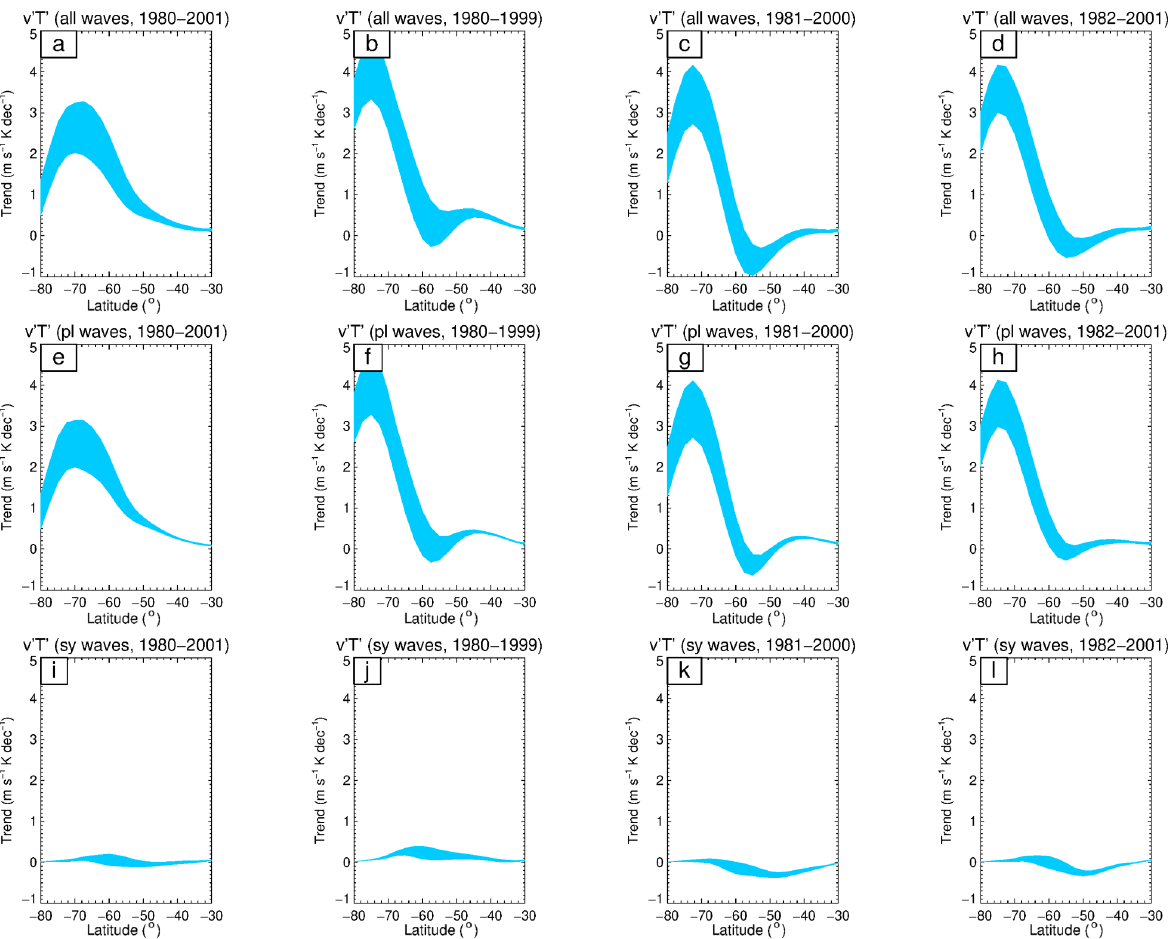
Figure 10. Sensitivity of the trends in eddy heat flux to time period, displayed as shaded envelopes representing the spread (maximum and minimum values) derived from ERA5, JRA-55, MERRA-2, and CFSR of the November trend in 30 to 100hPa vertically integrated eddy heat flux v (cid:48) T (cid:48) from 1980 to 2001 (a, e, i) , 1980 to 1999 (b, f, j) , 1981 to 2000 (c, g, k) , and 1982 to 2001 (d, h, i) due to all waves (a–d) , planetary waves (e–h) , and synoptic waves (i–l) . The units are m 2 s − 2 per decade. Panels (a) , (e) , and (i) are the same results as shown in the left column of Fig.